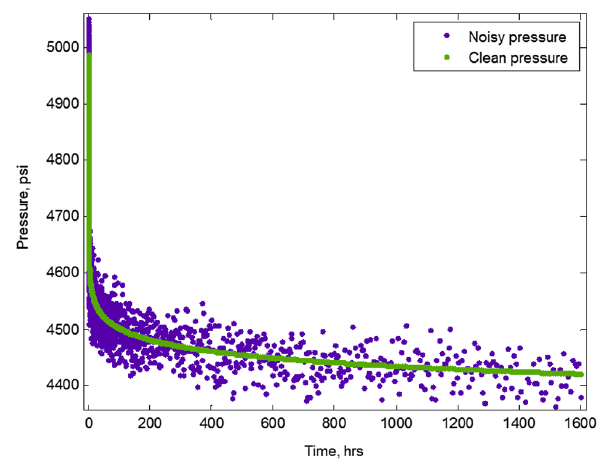
Fig. 2 Generated non-noisy (clean) pressure transient data and noisy pressure with 2% artificial normal